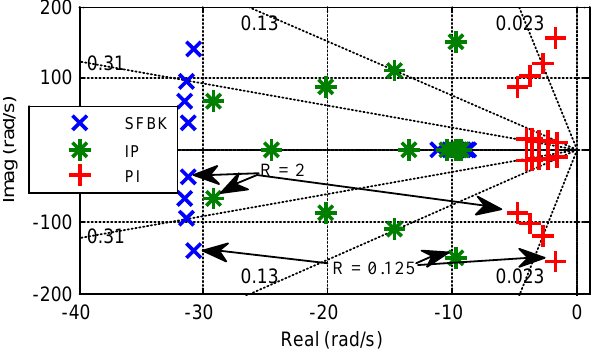
Figure 12. Loci of dominant poles with load inertia variation for PI, IP and SFBK controllers.